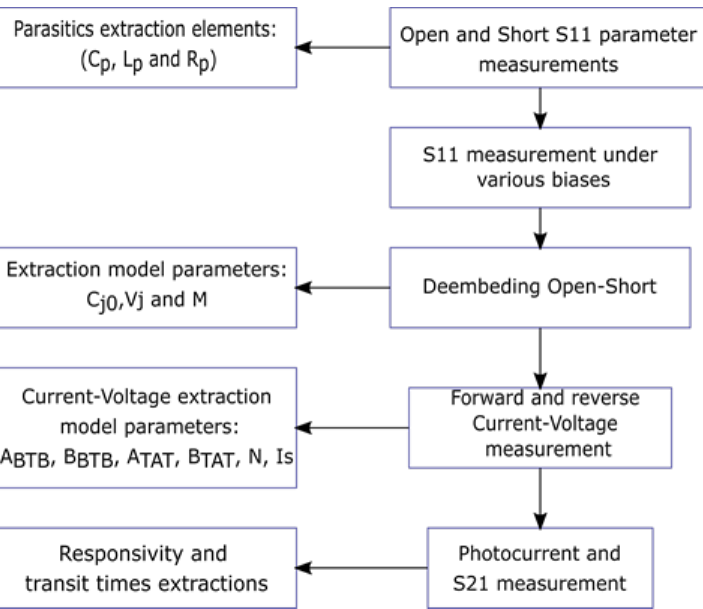
Table 4. Extracted parameter values of the UTC-PD de-embedding test structures.